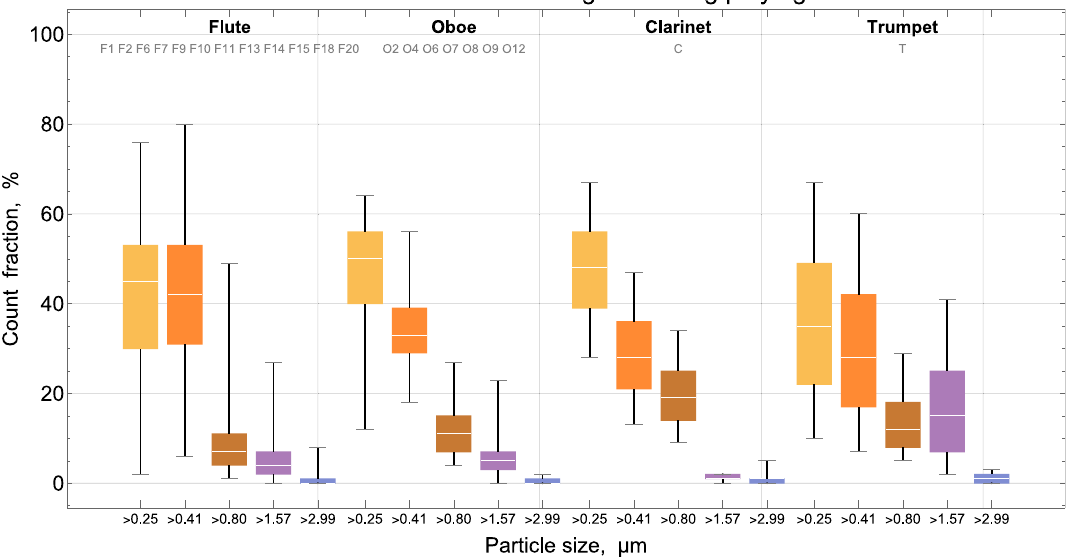
Figure 4. Size distribution of aerosol from playing wind instruments. White split indicates median, whiskers indicate lower and upper fence, box indicates 25% and 75%